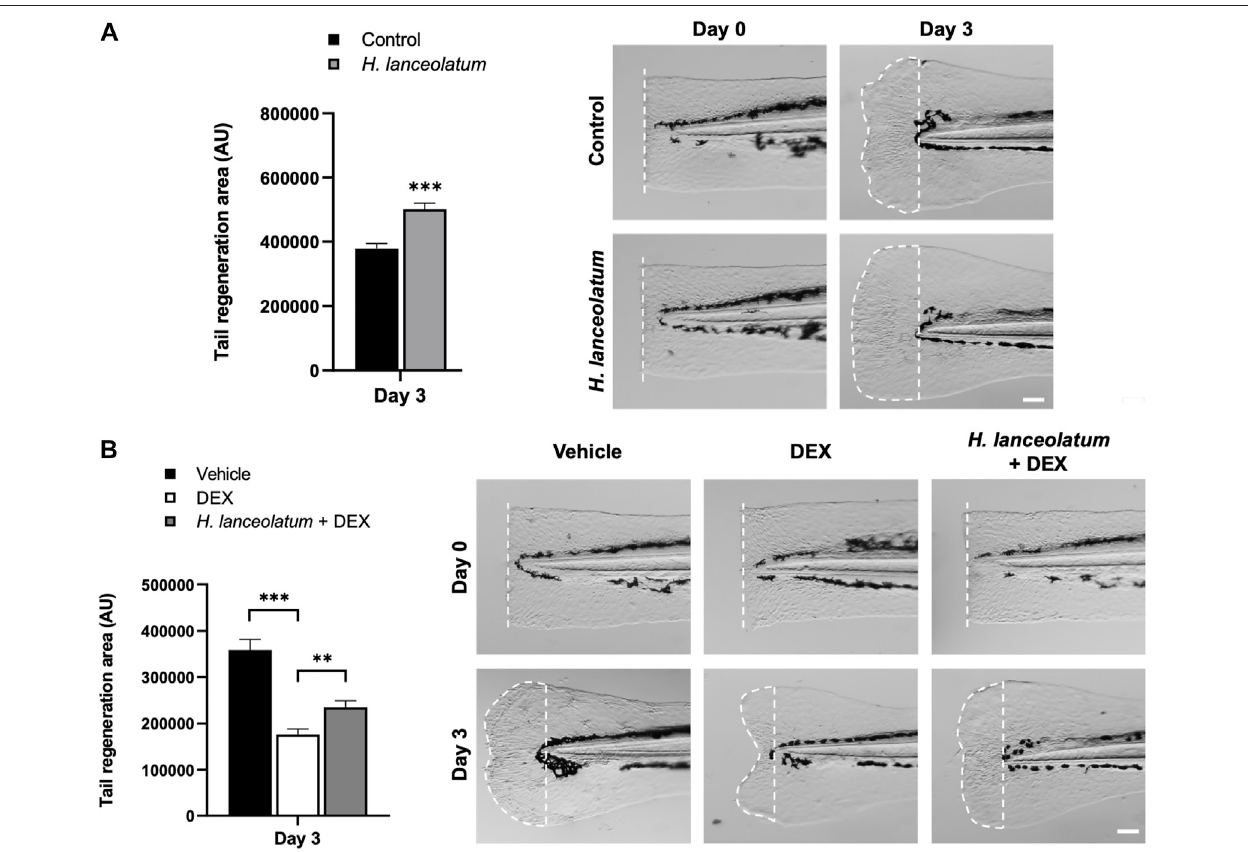
FIGURE 8 | H. lanceolatum aqueous extract improves tail regeneration in zebra fi sh eleutheroembryos. (A) Measurement of tail regeneration area (in arbitrary units) and representative pictures of eleutheroembryos incubated in E3 medium (Control) or H. lanceolatum aqueous extract at 0.3125 g/L ( H. lanceolatum ), 0- and 3-days post-amputation(dotted)of3-dpfeleutheroembryos. (B) Measurementoftailregenerationareaandrepresentativepicturesofeleutheroembryostreatedwiththevehicle (0.4% ethanol), dexamethasone (500µM, DEX) or H. lanceolatum aqueous extract + dexamethasone ( H. lanceolatum + DEX), 0- and 3-days post-amputation. Results are expressed as means ± SEM ( n = 20 – 39/group from 3 independent experiments). ** p < 0.01, *** p < 0.001 (Student t-test). Bar = 25